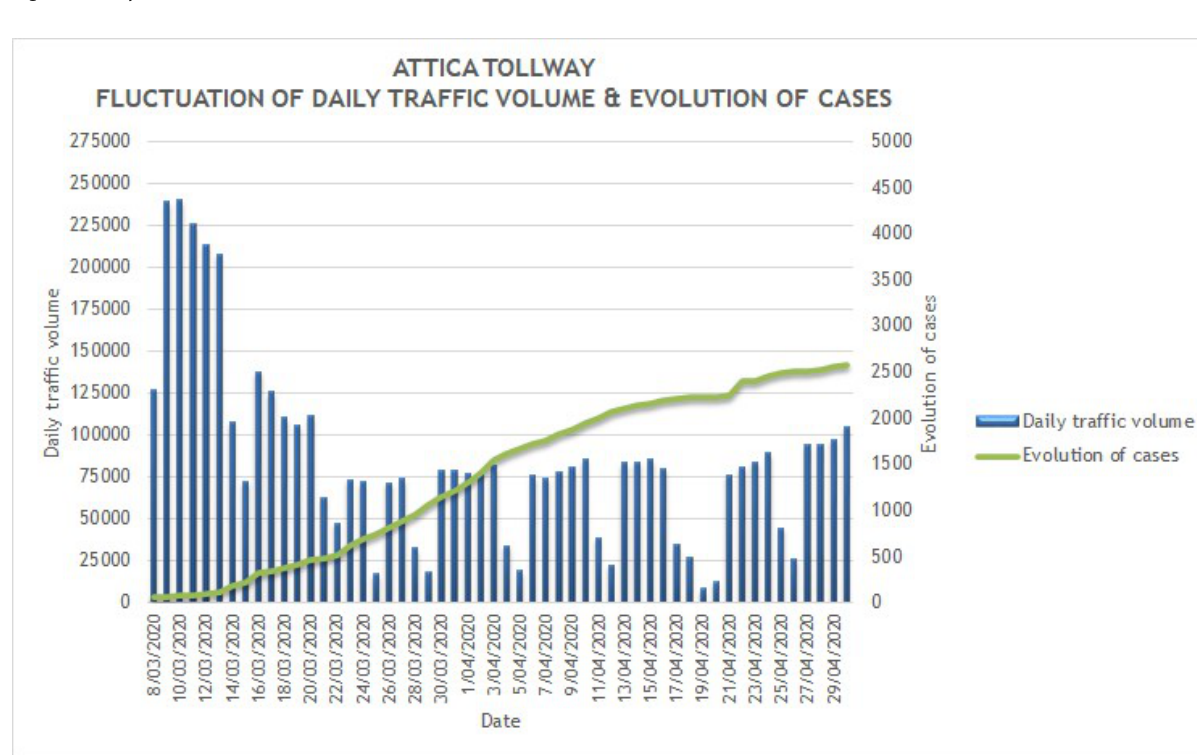
Figure 6: Daily new coronavirus cases